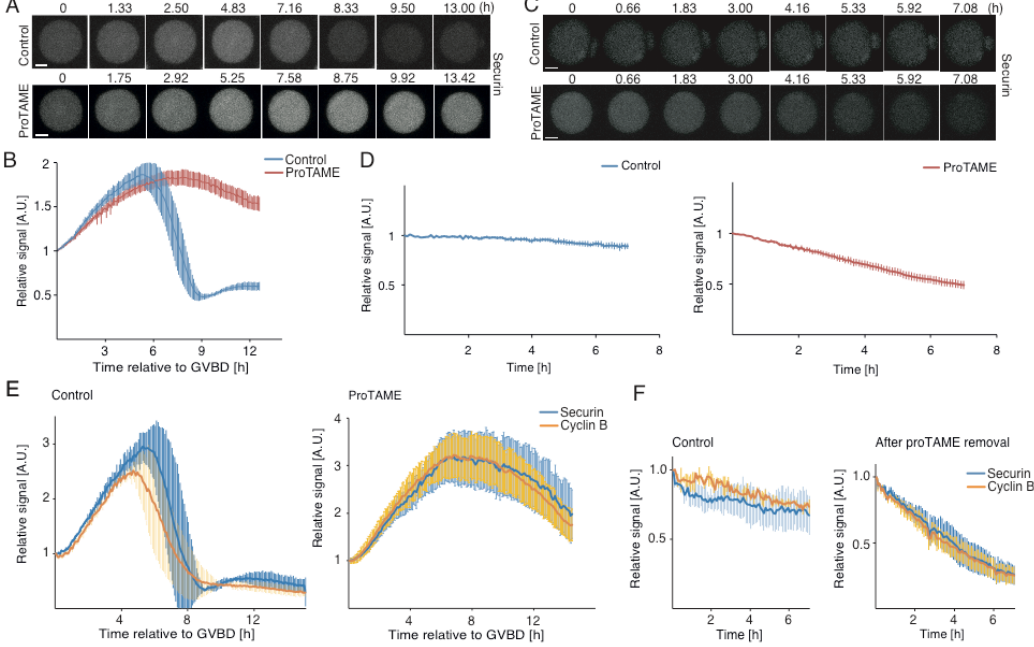
Figure 3. Oocytes arrested by proTAME show a low level of anaphase promoting complex / cyclosome (APC / C) activity. ( A ) Time frames from live cell microscopy showing the expression levels of microinjected SECURIN (grey) in various stages of meiotic maturation. Upper panels show the control cell, lower panels show the oocyte exposed to 5 µ M proTAME. Scale bar: 20 µ m. ( B ) Average SECURIN curves of control cells (blue, n = 5) and proTAME-treated cells (red, n = 11) with error bars. Time is relative to GVBD (a movie frame with GVBD or the first frame after GVBD represents time 0). Presented are representative results from a single experiment, which was repeated three times. ( C ) Time frames from live cell microscopy showing expression levels of microinjected SECURIN (grey) after the removal of proTAME from the culture media. Upper panels show the control cell, lower panels show cells previously exposed to 5 µ M proTAME. Scale bar: 20 µ m. ( D ) The left panel shows the average SECURIN curve with error bars of control cells (blue, n = 5) after proTAME removal; the right panel shows the average SECURIN curve with error bars of proTAME-treated cells (red, n = 11) after the removal of proTAME. The time is relative to the first frame after the removal of the inhibitor. Presented are representative results from a single experiment, which was repeated three times. ( E ) The left panel shows the average SECURIN (blue, n = 3) and CYCLIN B (yellow, n = 3) curves of control cells with error bars; the right panel shows the average SECURIN (blue, n = 6) and CYCLIN B (yellow, n = 8) curves of proTAME-treated cells with error bars. Time is relative to GVBD. Presented are results from a single experiment repeated twice. ( F ) The left panel shows the average SECURIN (blue, n = 3) and CYCLIN B (yellow, n = 2) curves of control cells, from the time point corresponding to proTAME removal, with error bars; the right panel shows the average SECURIN (blue, n = 6) and CYCLIN B (yellow, n = 7) curves of proTAME-treated cells after the removal of proTAME with error bars. Time is relative to the first frame after the removal of inhibitor. Presented are results from a single experiment; the experiment was repeated twice.